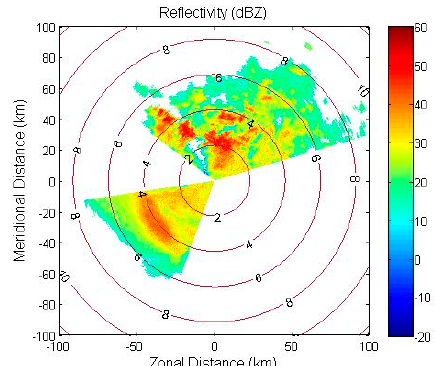
Figure 5. Radar reflectivity PPI for two separated rain events at 05:45 UTC on 21 April 2014.